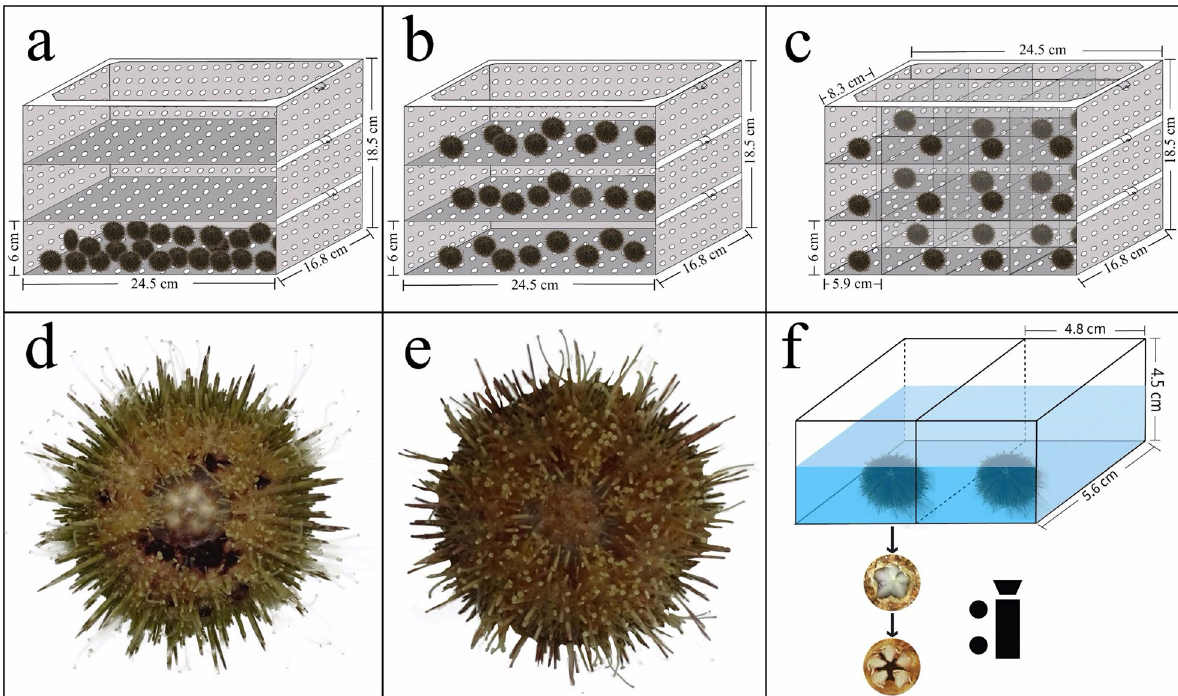
Figure 7. Diagrams of the experimental cages used for the groups A ( a ), B ( b ) and C ( c ), the sea urchin with the spotting disease ( d ) and without the disease ( e ) and the devices used for measuring the Aristotle’s lantern reflex ( f